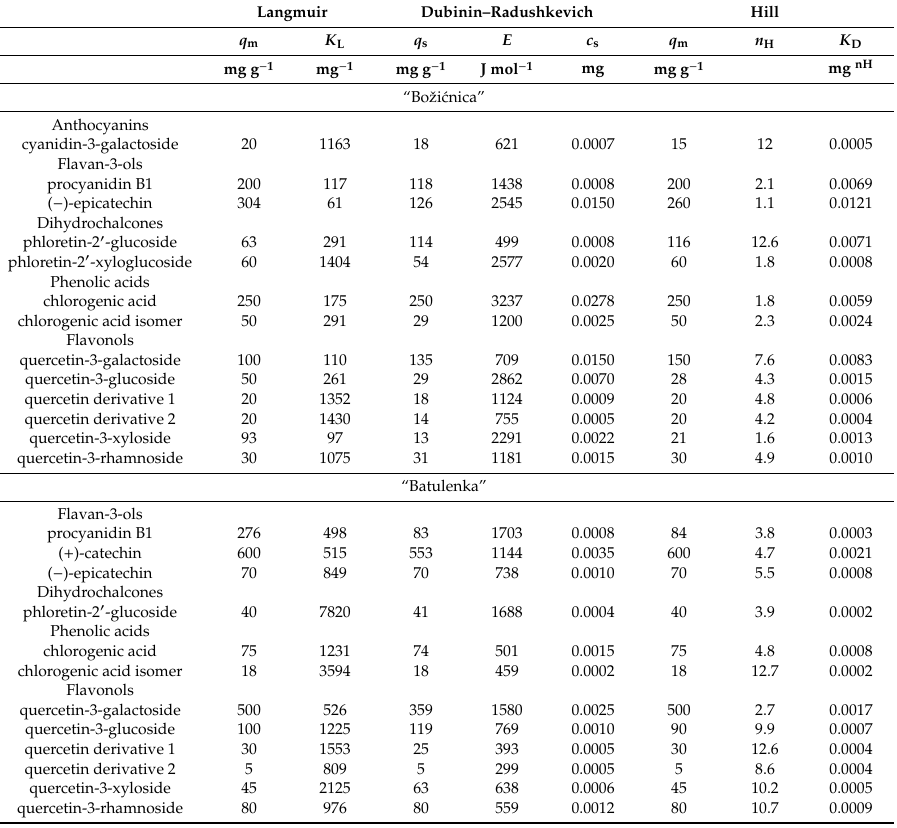
Table 2. Parameters of Langmuir, Dubinin–Radushkevich, and Hill adsorption isotherms obtained by improved non-linear modeling of adsorbed polyphenols from “Boži´cnica” and “Batulenka” peel onto β -glucan.